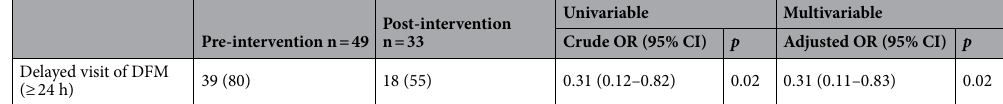
Table 3. The logistic regression analysis of delayed maternal visit of DFM. Adjusted for maternal age and parity. OR odds ratio, CI confidential interval, DFM decreased fetal movement. Data are n (%).